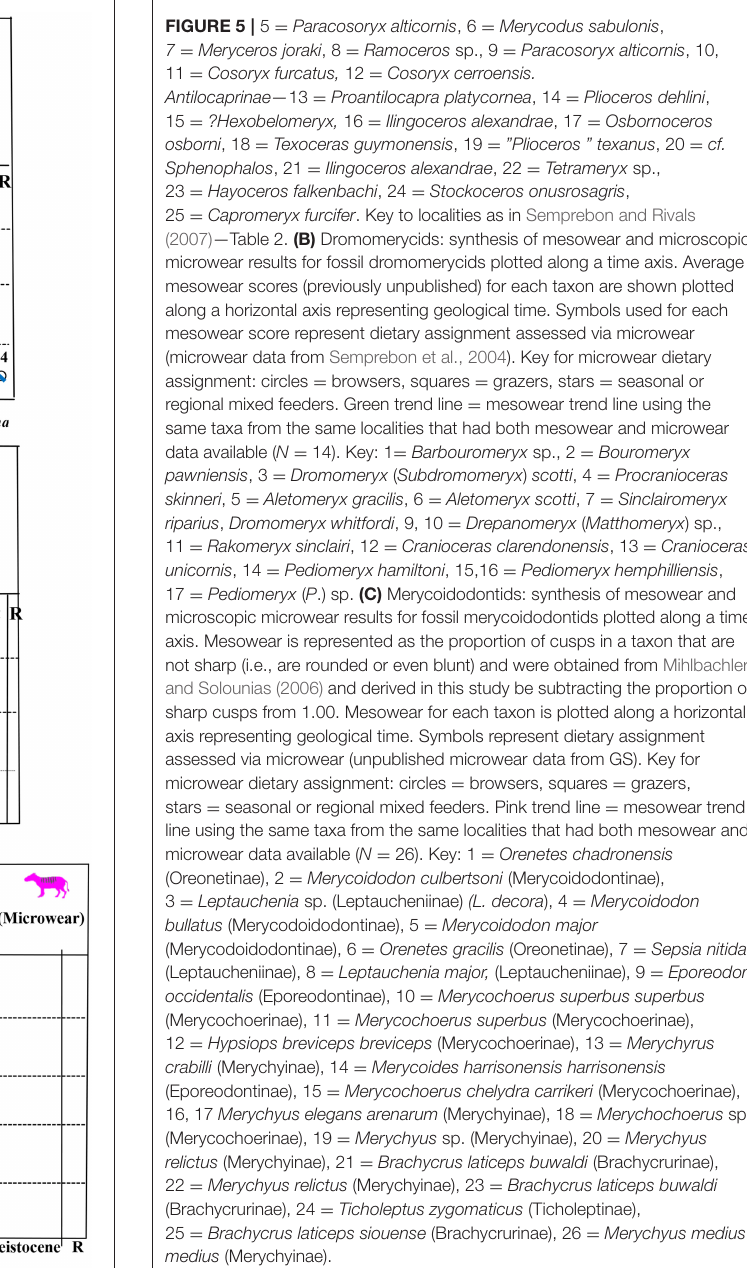
16, 17 Merychyus elegans arenarum (Merychyinae), 18 = Merychochoerus sp. (Merycochoerinae), 19 = Merychyus sp. (Merychyinae), 20 =